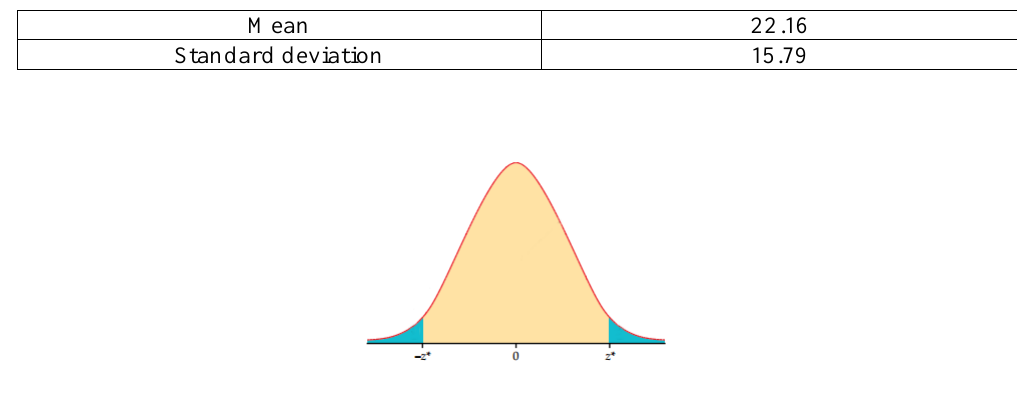
Mean and Standard Deviation for Monetary